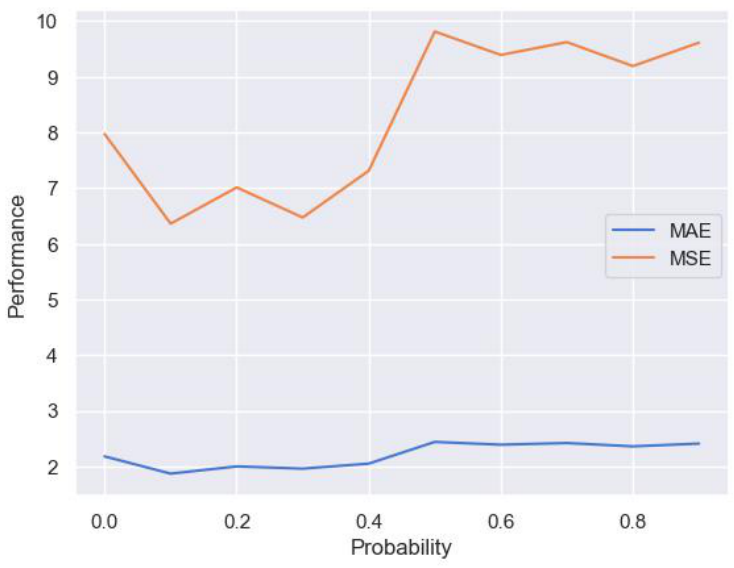
Figure 8. Results with different dropout probabilities.